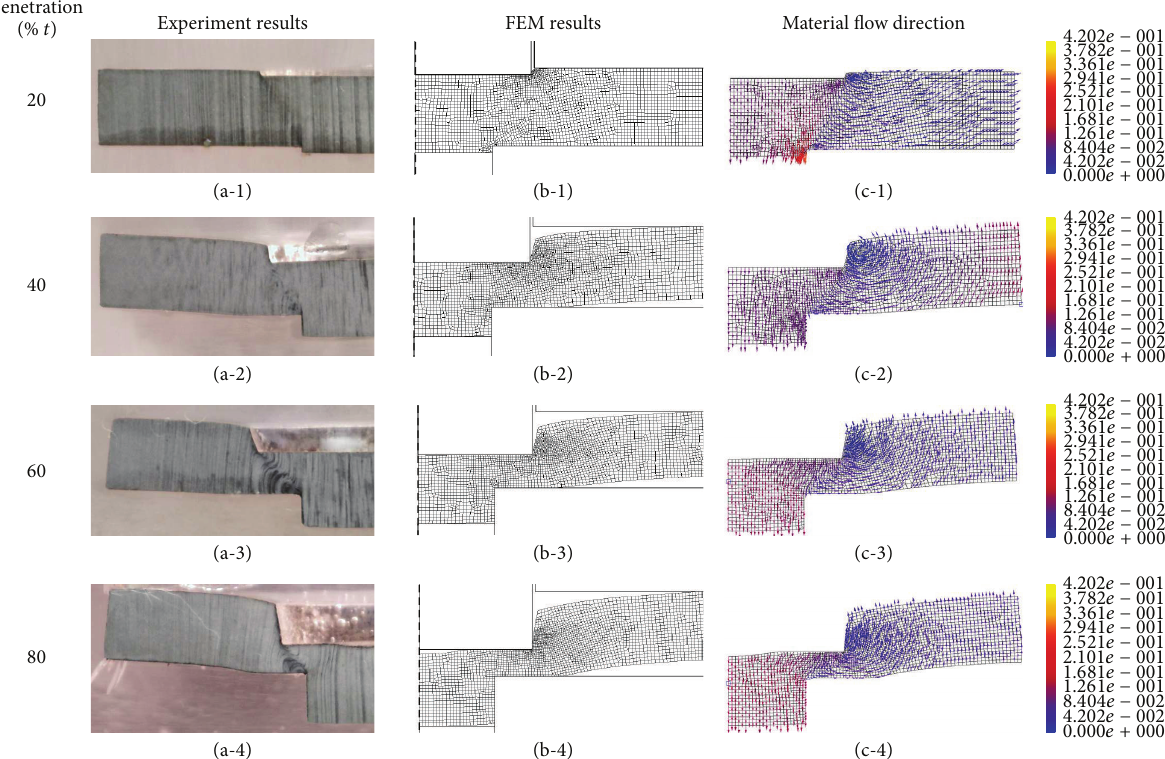
Figure 7: Comparison of formation behavior analysis between experimental and FEM simulation results.